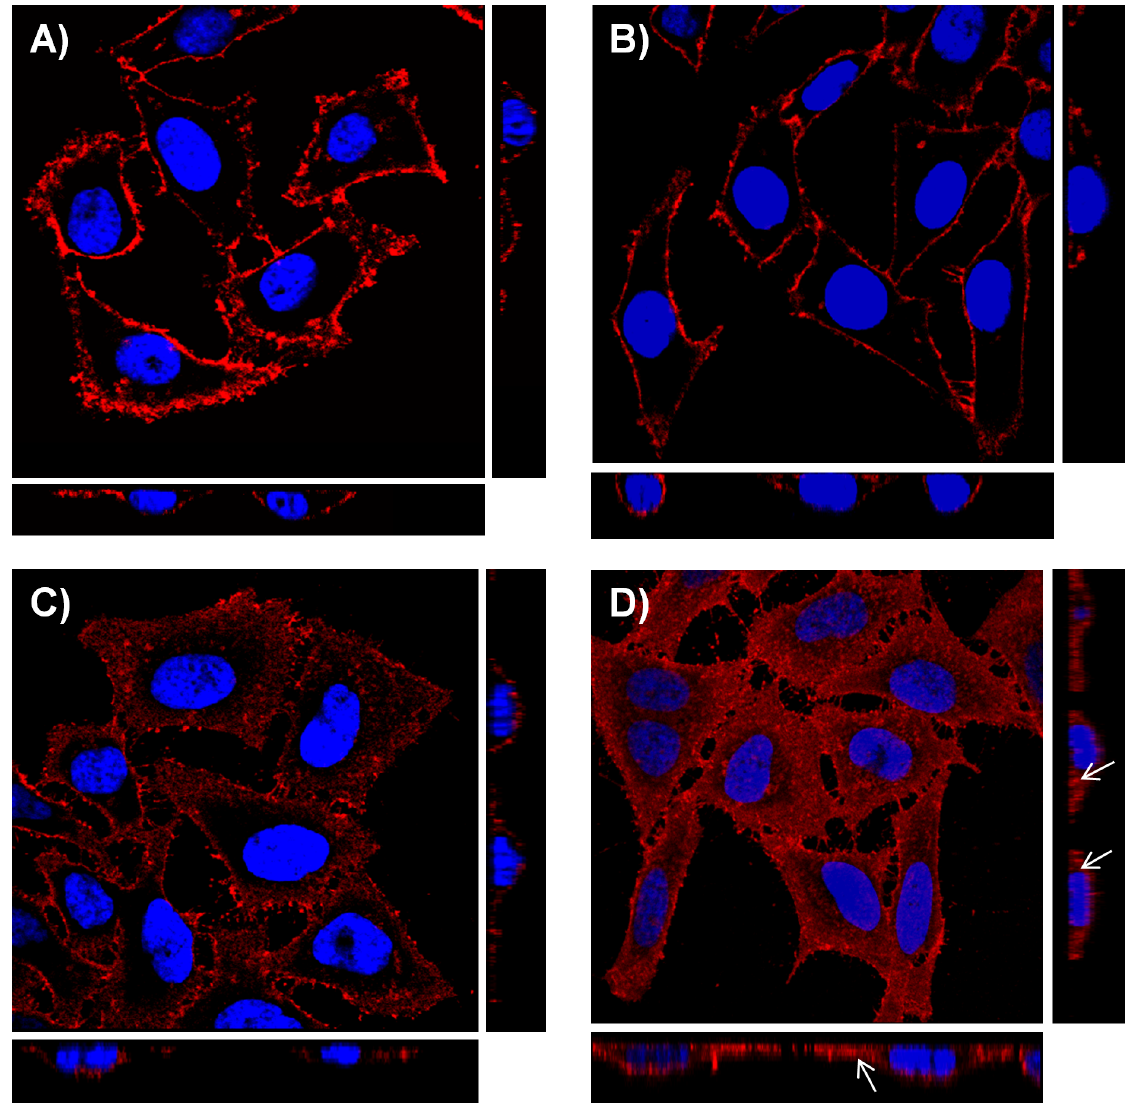
Figure 1. Binding and internalization of rCARDS toxin in HeLa cells. A) rCARDS toxin localizes to HeLa cell surfaces. HeLa cell monolayers were treated with 10 m g/ml of rCARDS toxin for 1 h at 4 u C, stained with rabbit polyclonal antibodies reactive against CARDS toxin (1:1000) and counterstained with goat anti-rabbit IgG conjugated Alexa Fluor-633 antibodies (red). Cell nuclei were stained with DAPI (4 9 ,6-Diamidino-2- Phenylindole, Dihydrochloride). Z series at 0.5 micrometer sections were obtained by combining a series of x-y scans taken along the z axis. B-D) rCARDS toxin internalization is time dependent. HeLa cells were treated with 10 m g/ml of rCARDS toxin for B) 15 min; C) 30 min; and D) 1 h at 37 u C. Cells were processed as described above. White arrows point to internalized rCARDS toxin based upon horizontal and vertical z